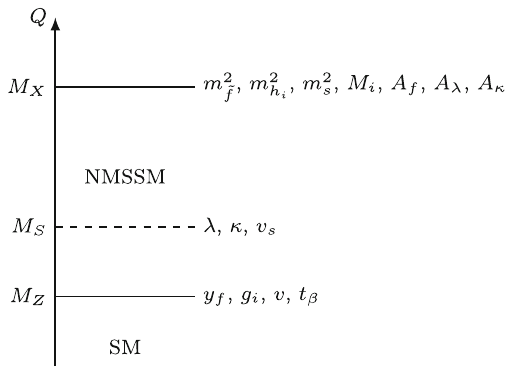
Fig. 1 CMSSM boundary value problem